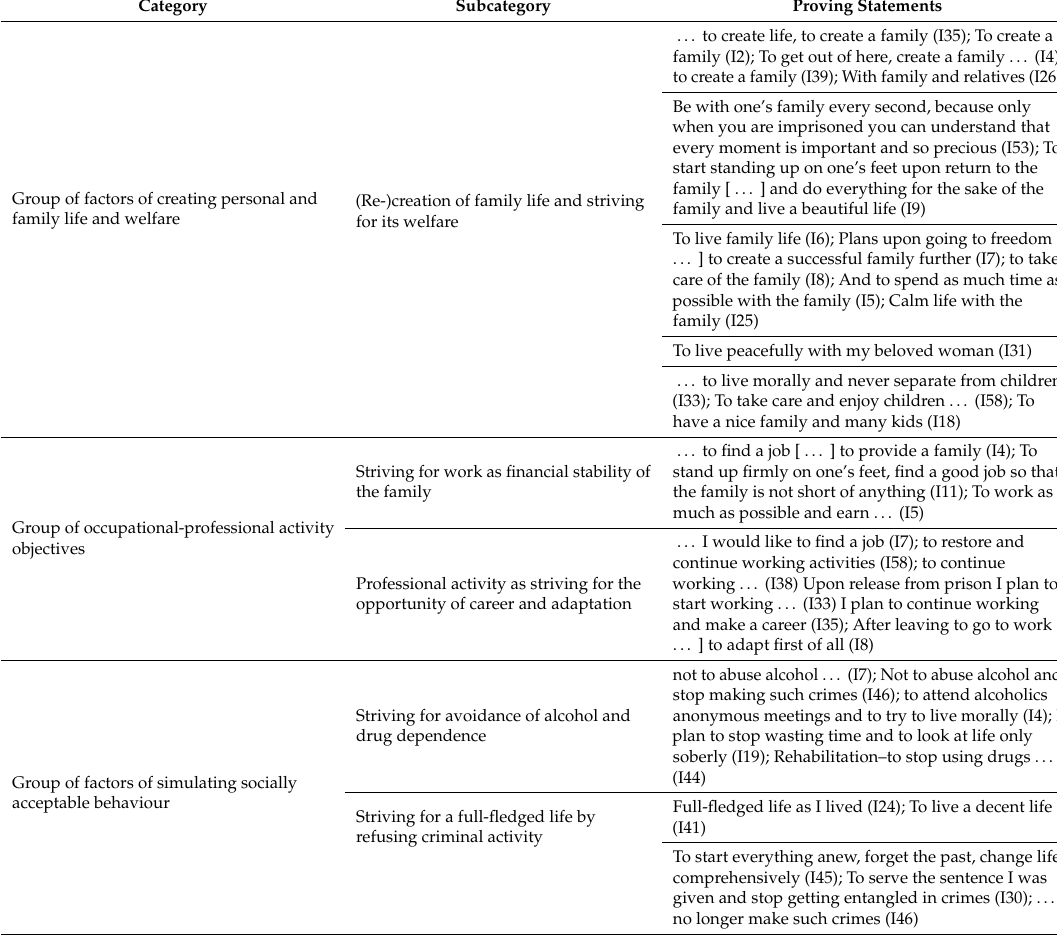
Table 4. Simulation of goals and priorities of life in